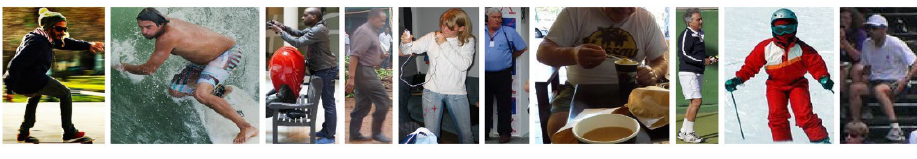
Figure 12. Test image.